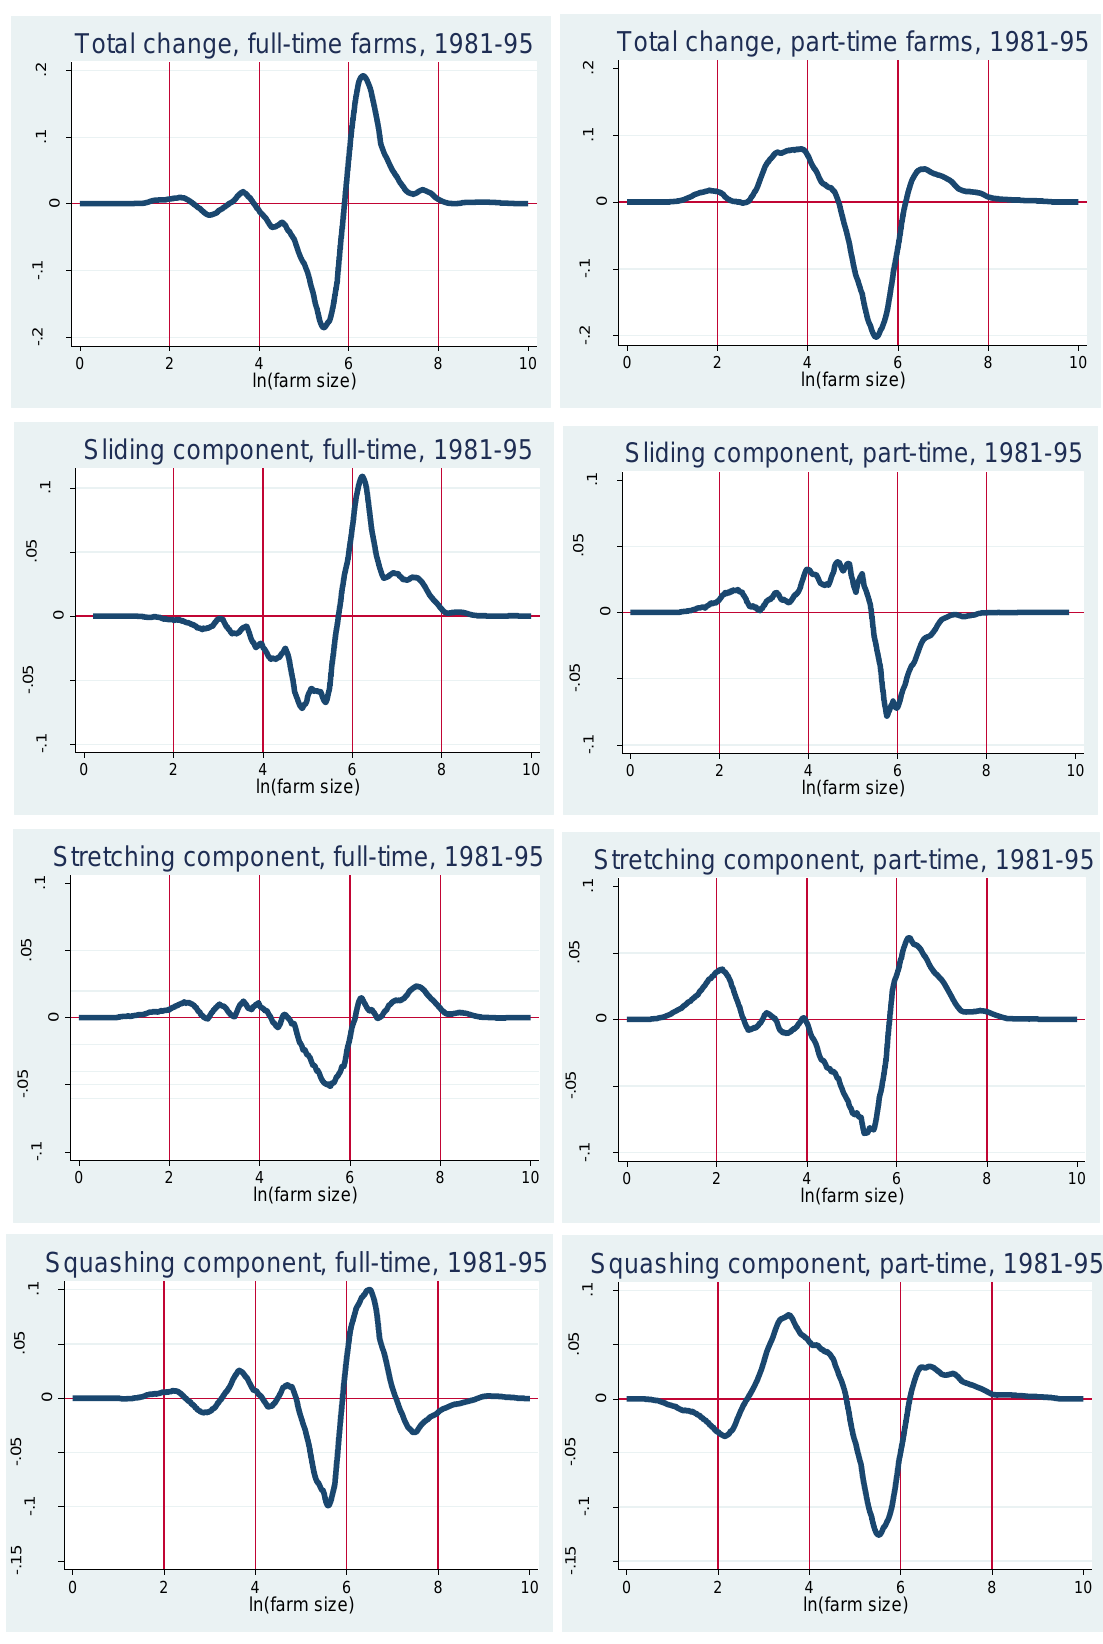
Figure 6. Decomposition of changes in farm size distribution, 1981 to 1995.